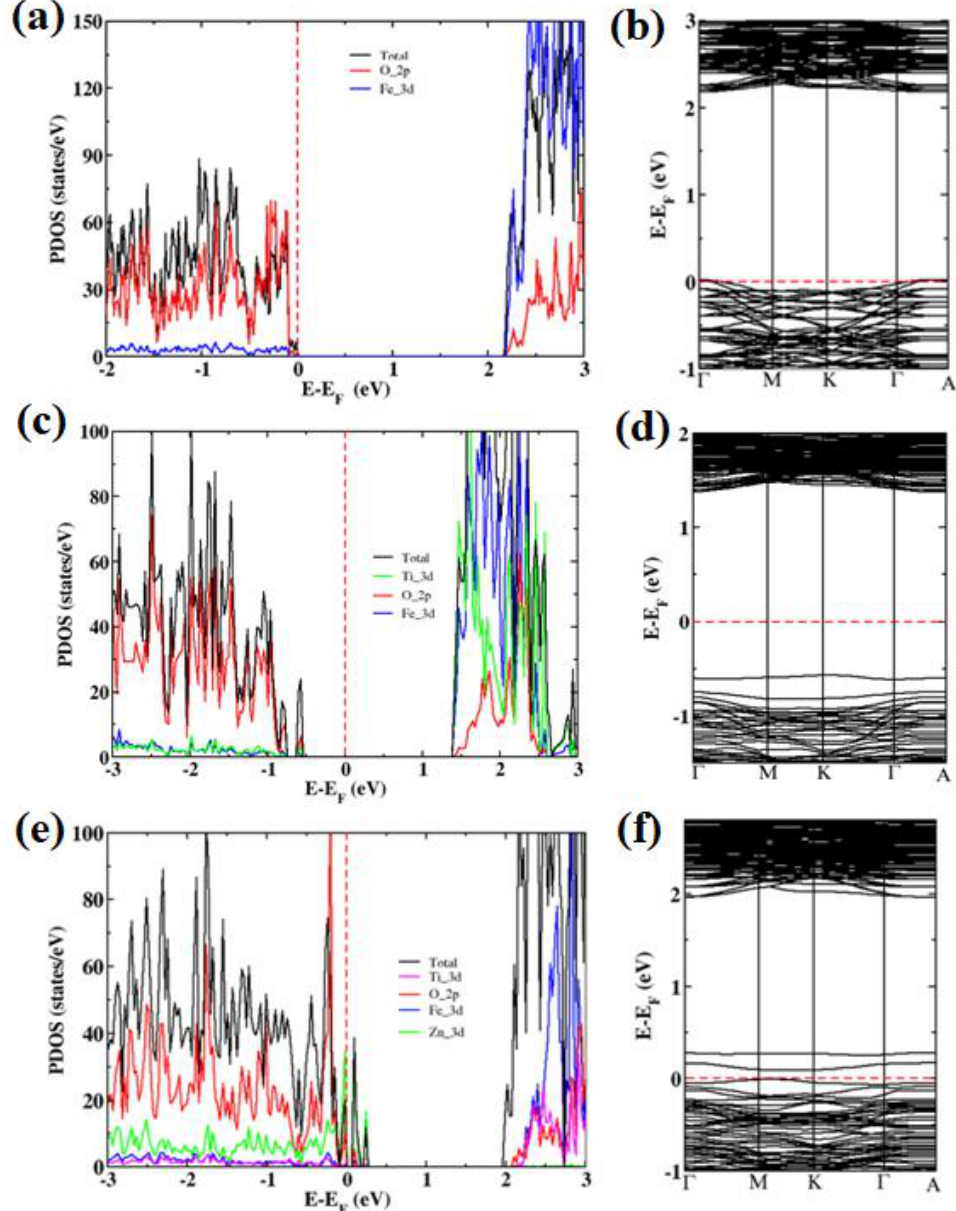
Figure 3. PDOS and band structure of pristine {0001} α -Fe 2 O 3 surface ( a , b ), (Ti)-doped {0001} α -Fe 2 O 3 surface ( c , d ), and (Zn, Ti)-doped {0001} α -Fe 2 O 3 surface ( e , f ). The Fermi level is set to zero.